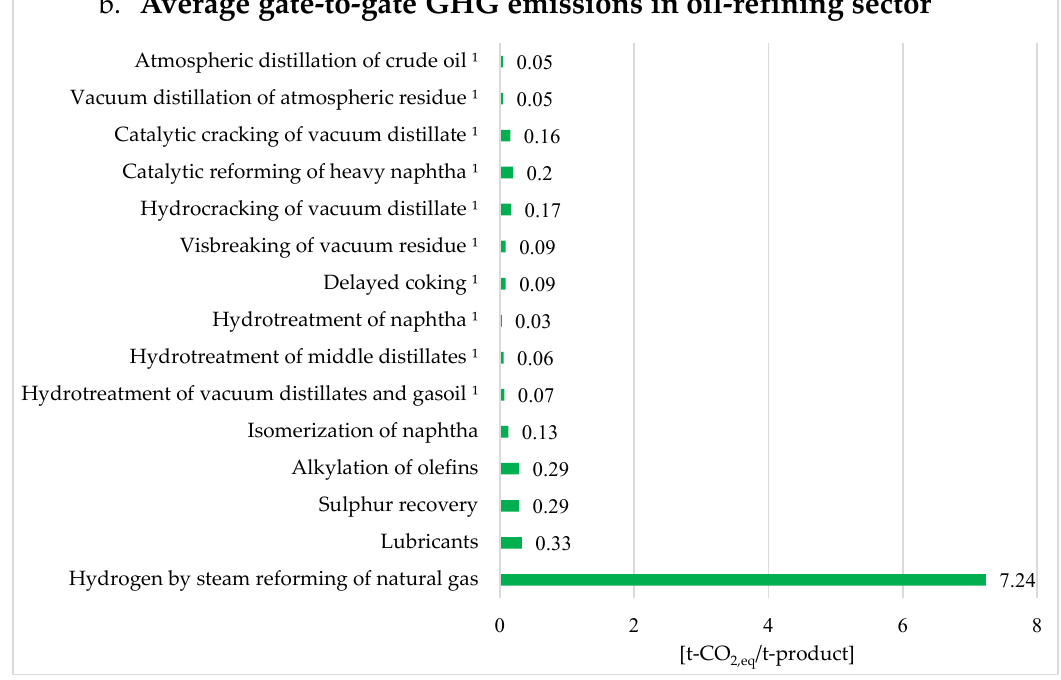
Figure 3. Average gate-to-gate greenhouse gas emission factors related to the main processes and products of the (petro)chemical (Panel ( a ), in blue) and oil refining (Panel ( b ), in green) industries. 1 Expressed per metric ton of feedstock (instead of per metric ton of product). Data from [48–54].